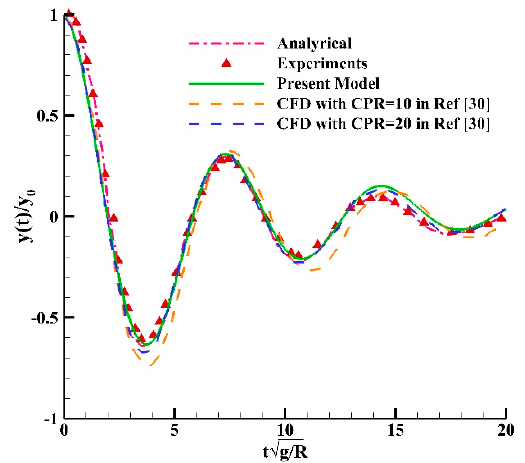
Figure 7. Comparison of various results for free decay amplitude variation of a circular cylinder in still water.